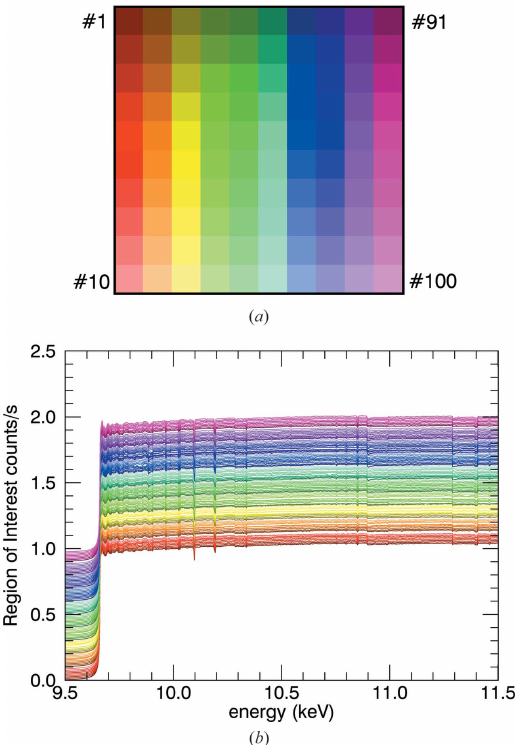
Figure 14 ( a ) Colour palette for each pixel in fluorescence plots used in this paper. Some plots appear dominated by pink/purple colours because higher- numbered pixels are plotted last. ( b ) ROI normalized by edge height and offset according to pixel number. Little divergence between pixels is seen.